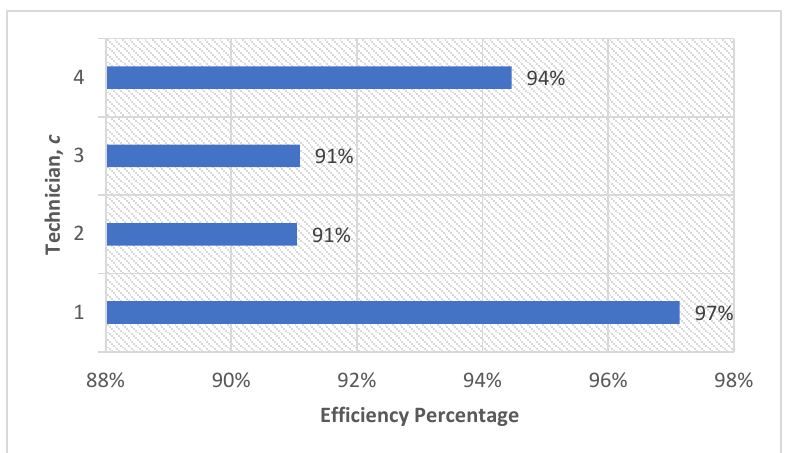
Figure 14. The efficiency percentages for technicians.